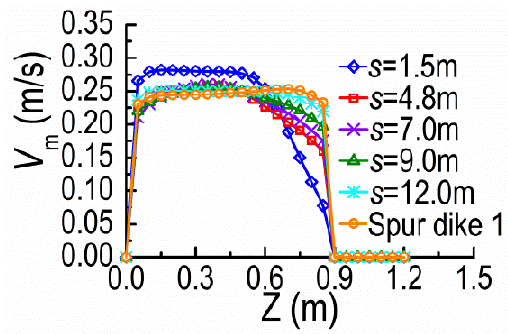
Figure 11. V m along Z-direction at the cross-section B.